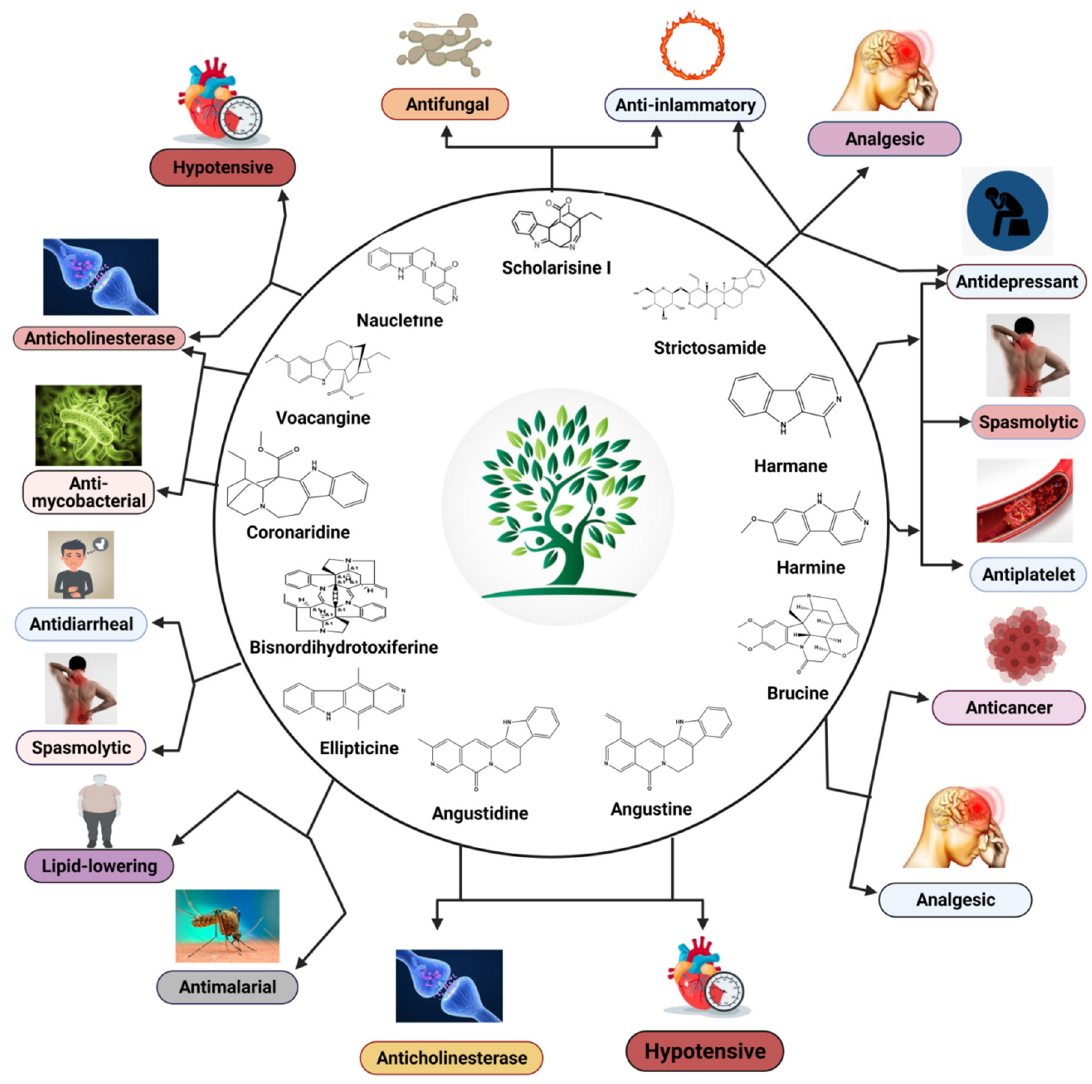
Figure 19. An overview of the pharmacological activities of major indole alkaloids.